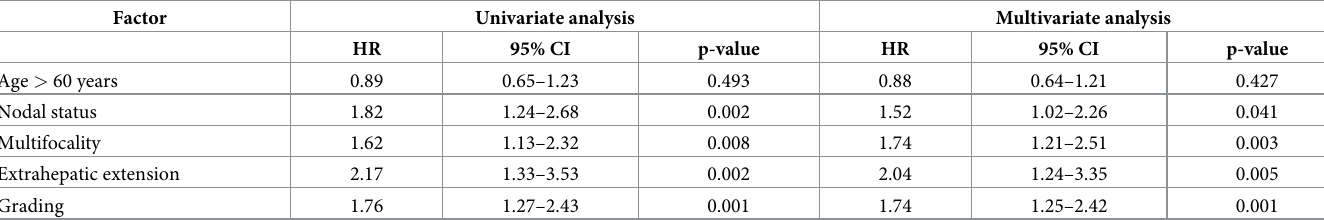
Table 2. Uni- and multivariate Cox proportional hazards regression model evaluating the MEGNA